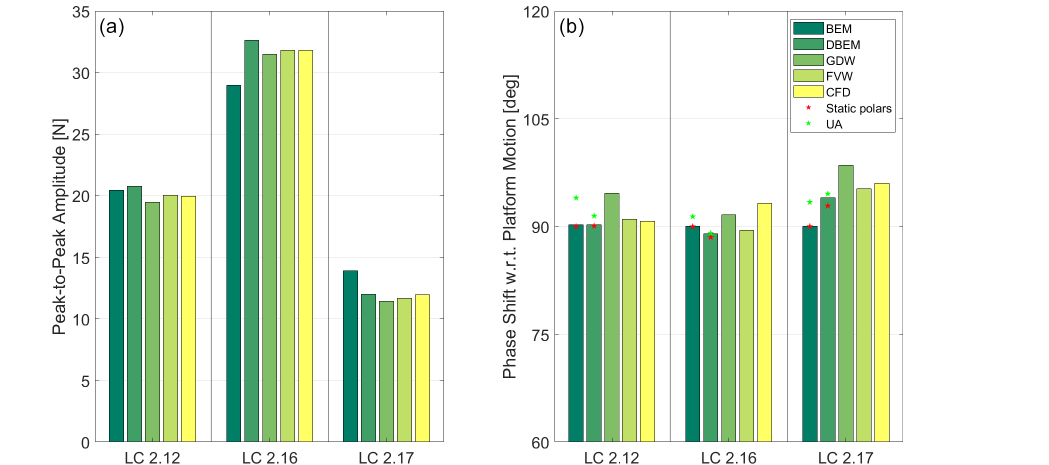
Figure 20. (a) Aerodynamic rotor thrust peak-to-peak amplitude in Load Case 2.12 (constant rotor speed and blade pitch), 2.16 (varying rotor speed), and 2.17 (varying blade pitch). (b) Phase shift with regard to the platform